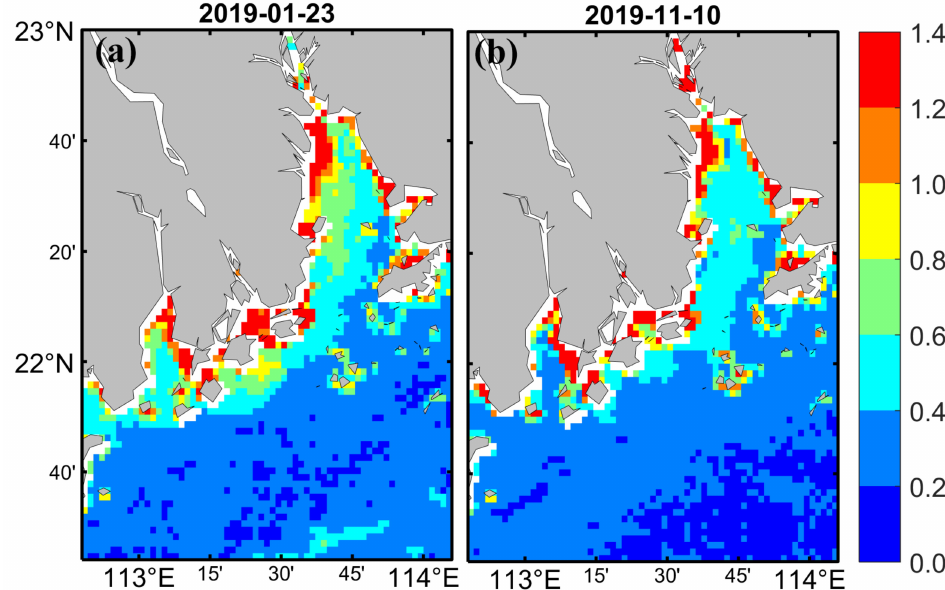
Figure 3. SST standard deviations for 23 January ( a ) and 10 November 2019 ( b